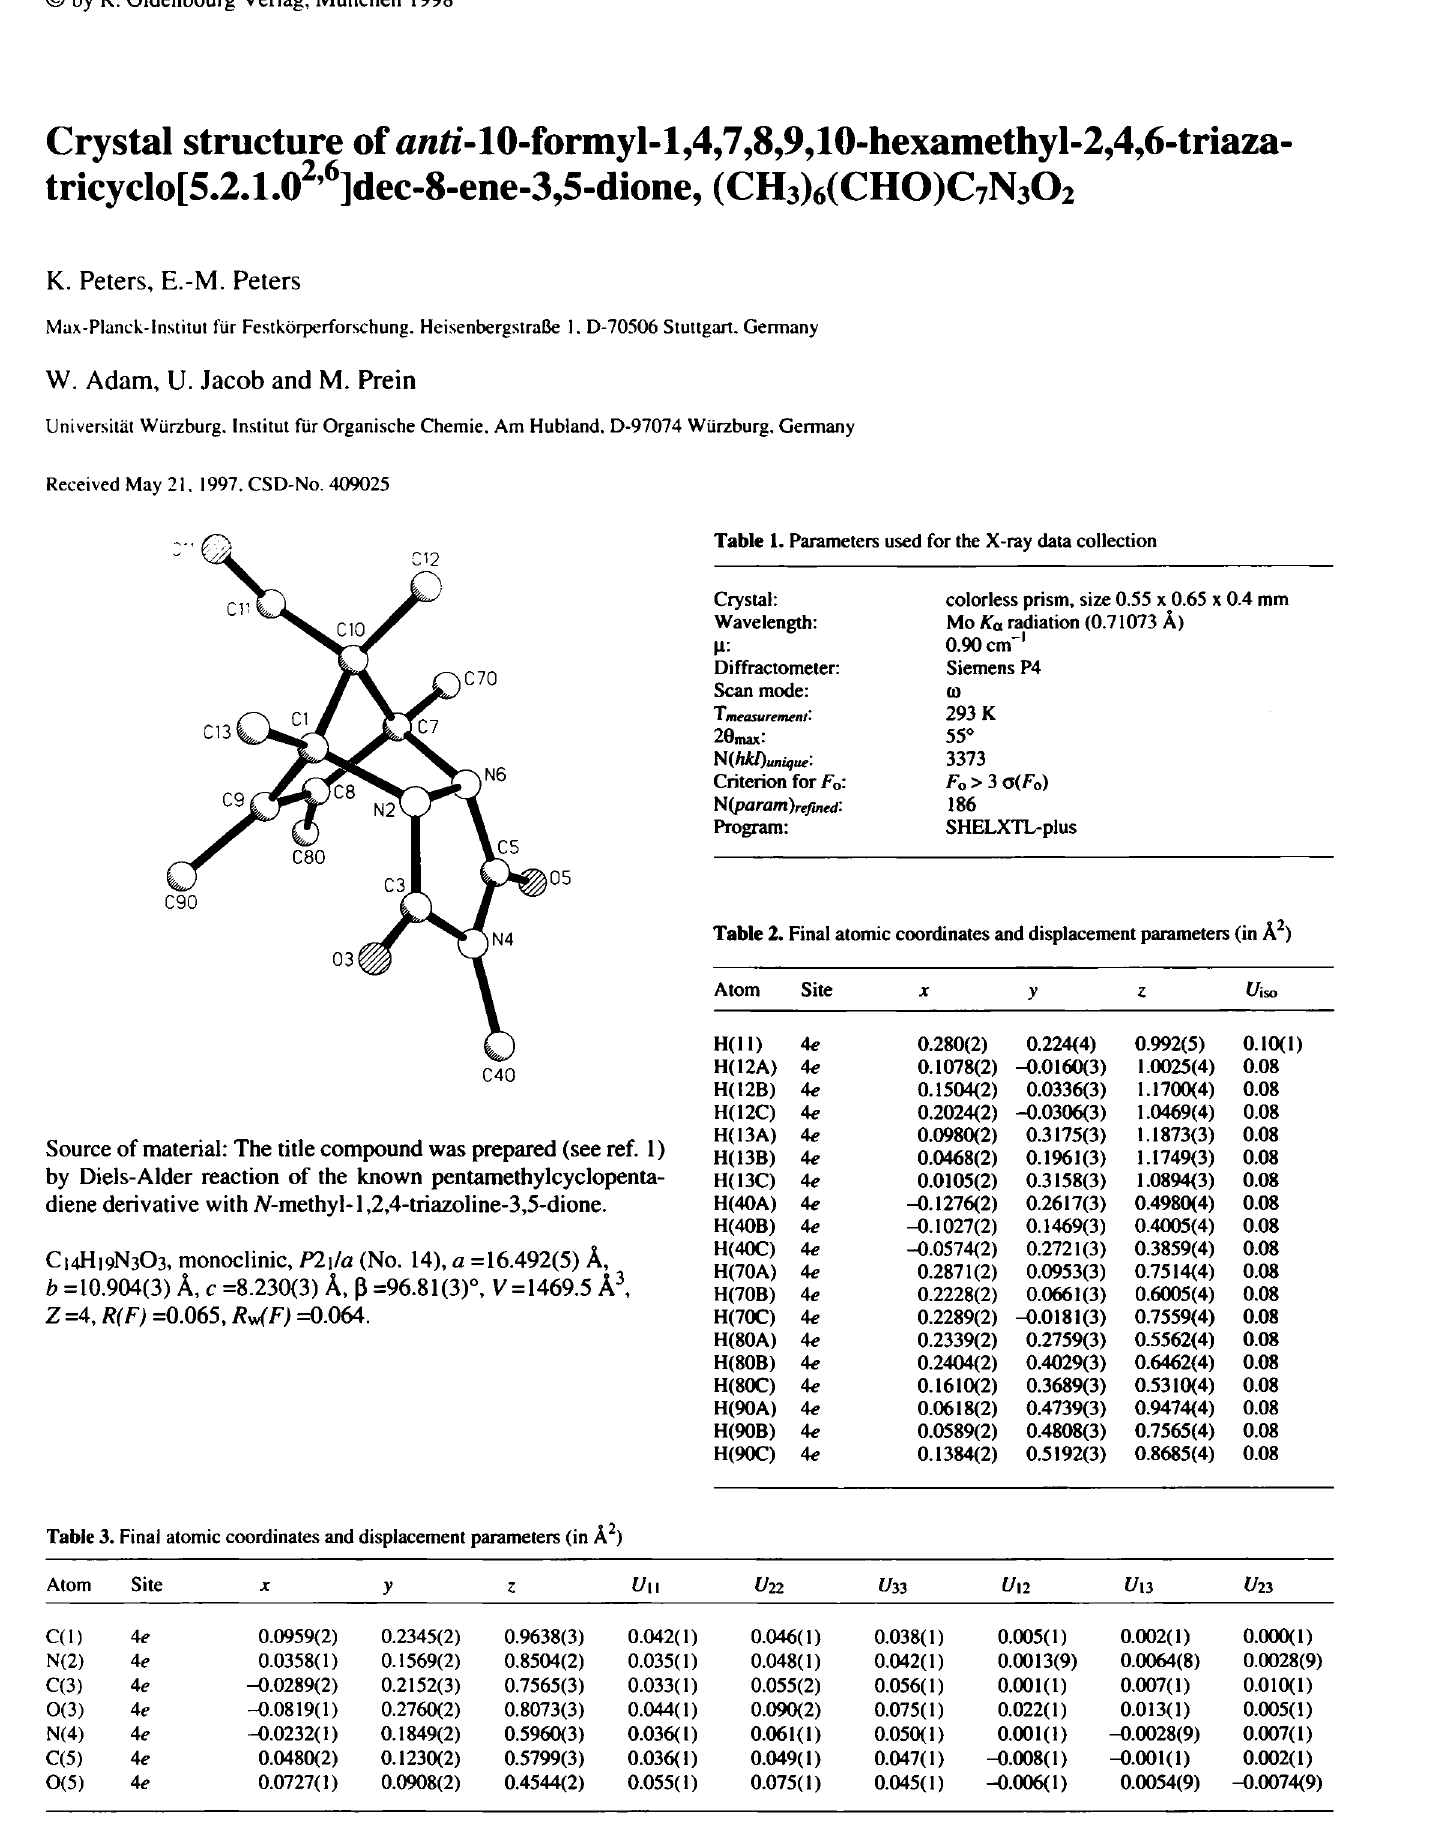
Table 3. Final atomic coordinates and displacement parameters (in Â^)